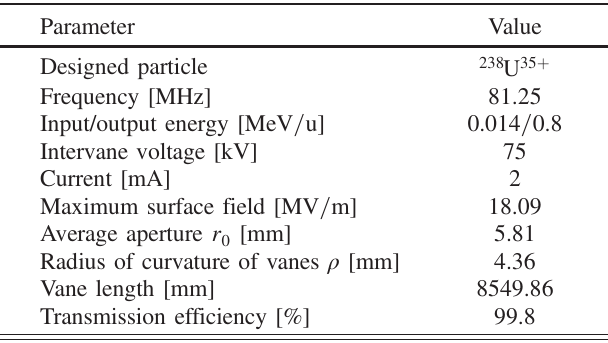
TABLE I. Main beam dynamics parameters of HIAF RFQ.